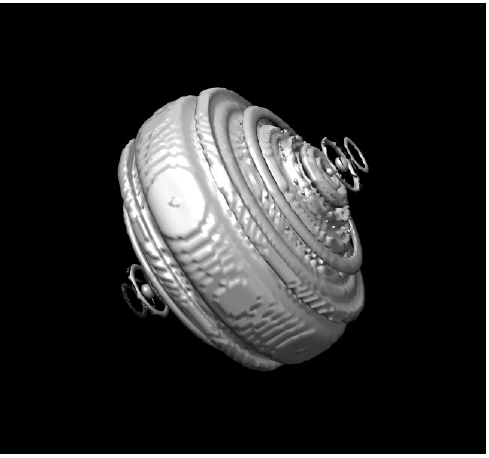
Figure 6. Reconstructed diffraction volume from two particles per shot (randomly